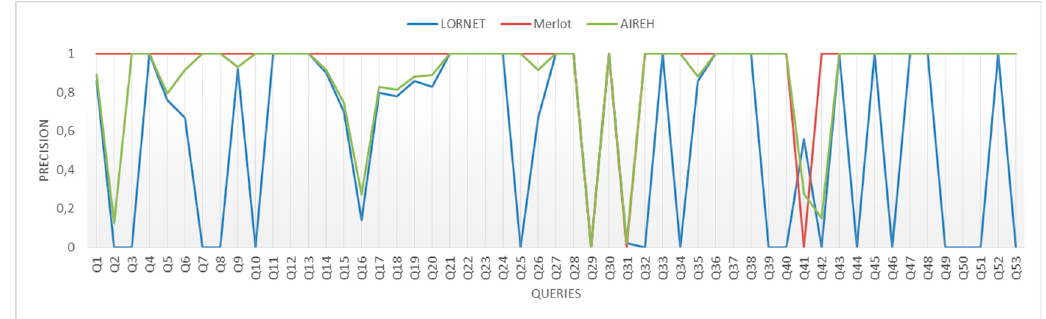
Figure 8. Comparison of relevant metadata documents from learning objects (LOs).